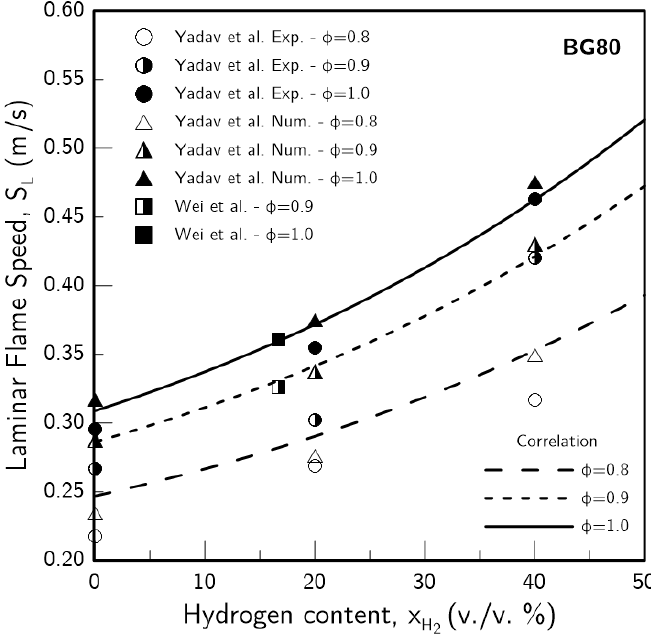
Figure 9. Laminar flame speed of H -enriched BG80/air flames. Symbols are the literature results, 2 and lines are the application of the correlation of this